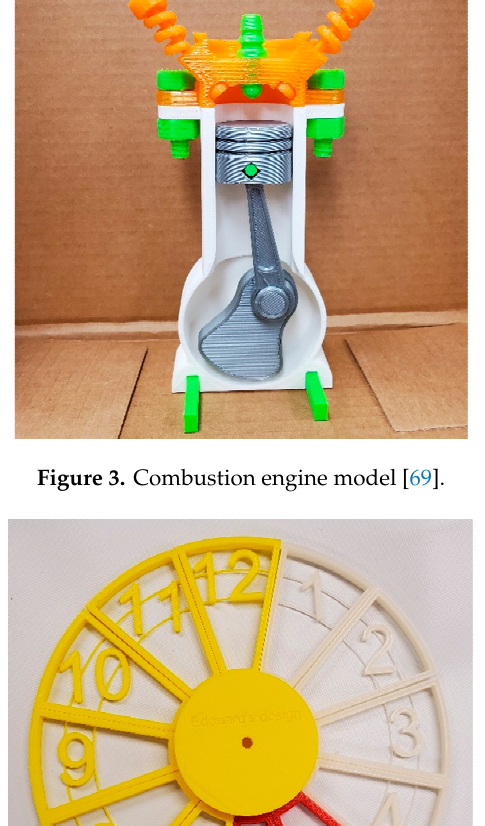
Figure 4. Clock model [65].